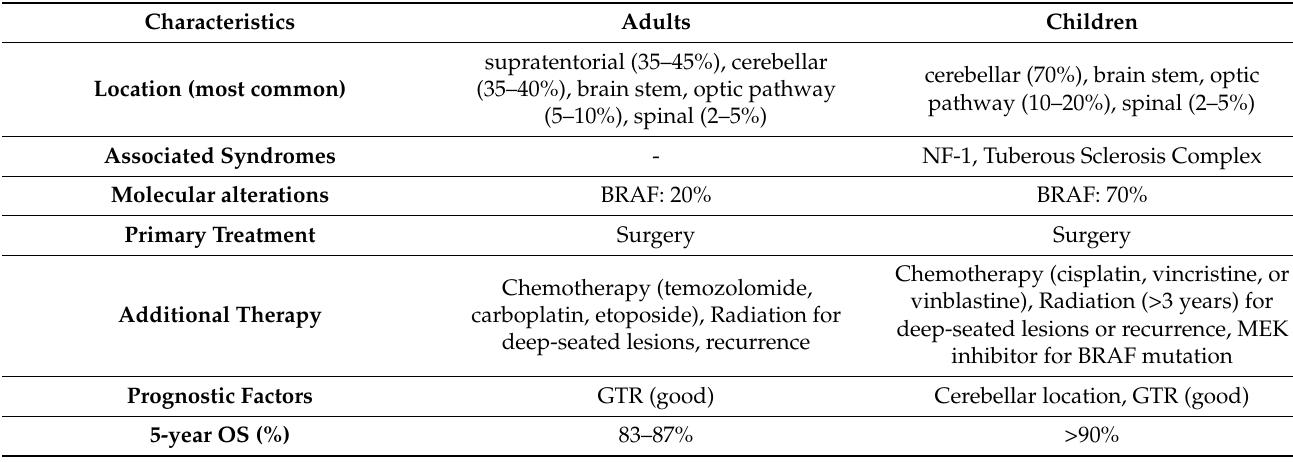
Table 3. Characteristics for adult and pediatric pilocytic astrocytoma, based on data from the following references [5,6,13,54– 58,64–66,75]. Abbreviations: OS = overall survival, NF = neurofibromatosis, GTR = gross total resection, STR = subtotal resection, MEK inhibitor = mitogen-activated protein